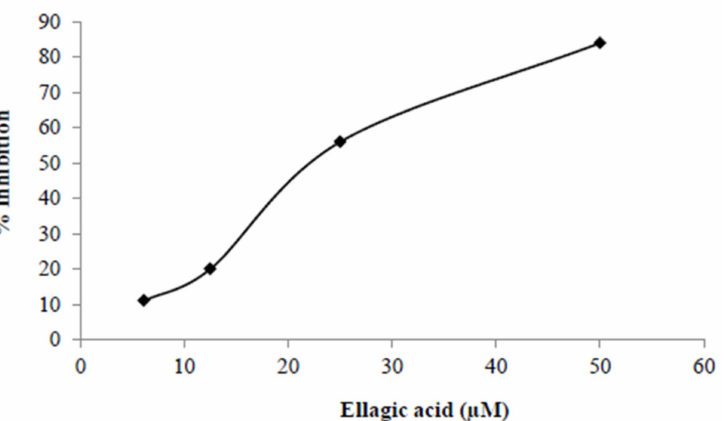
Figure 2. Percent inhibition of HIV-1 replication in TZM-bl cells by ellagic acid (EA). EA was added either 1 h before (“pre-treatment”) or after 4 h of exposure to HIV-1 JRCSF/NanoLuc and following washing off the virus (“post-treatment”). HIV replication in the cells was measured by detection of nano luciferase secreted into the cell culture supernatants using the Nano-Glo Luciferase detection assay 48 h post-challenge and was compared to HIV-1 infection without EA to calculate %Inhibition. %Inhibition = [(replication without EA − replication with EA)/replication without EA] × 100. Bars show the mean + SD of three independent experiments. All differences were significant at p -values of <0.05 versus the untreated control.